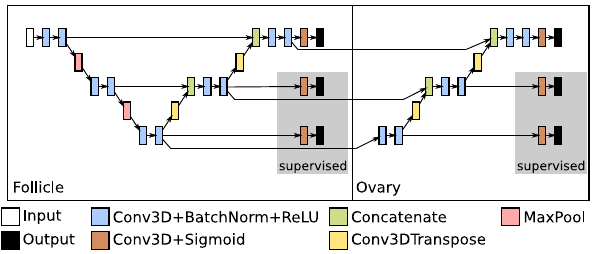
Figure 5. Example of the second proposed U-Net extension, EXT 2—U-Net with a series of additional decoders. The first stage detects follicles, while the additional decoders in the second stage identify the ovary. Deep Supervision outputs are shown in a grey box.